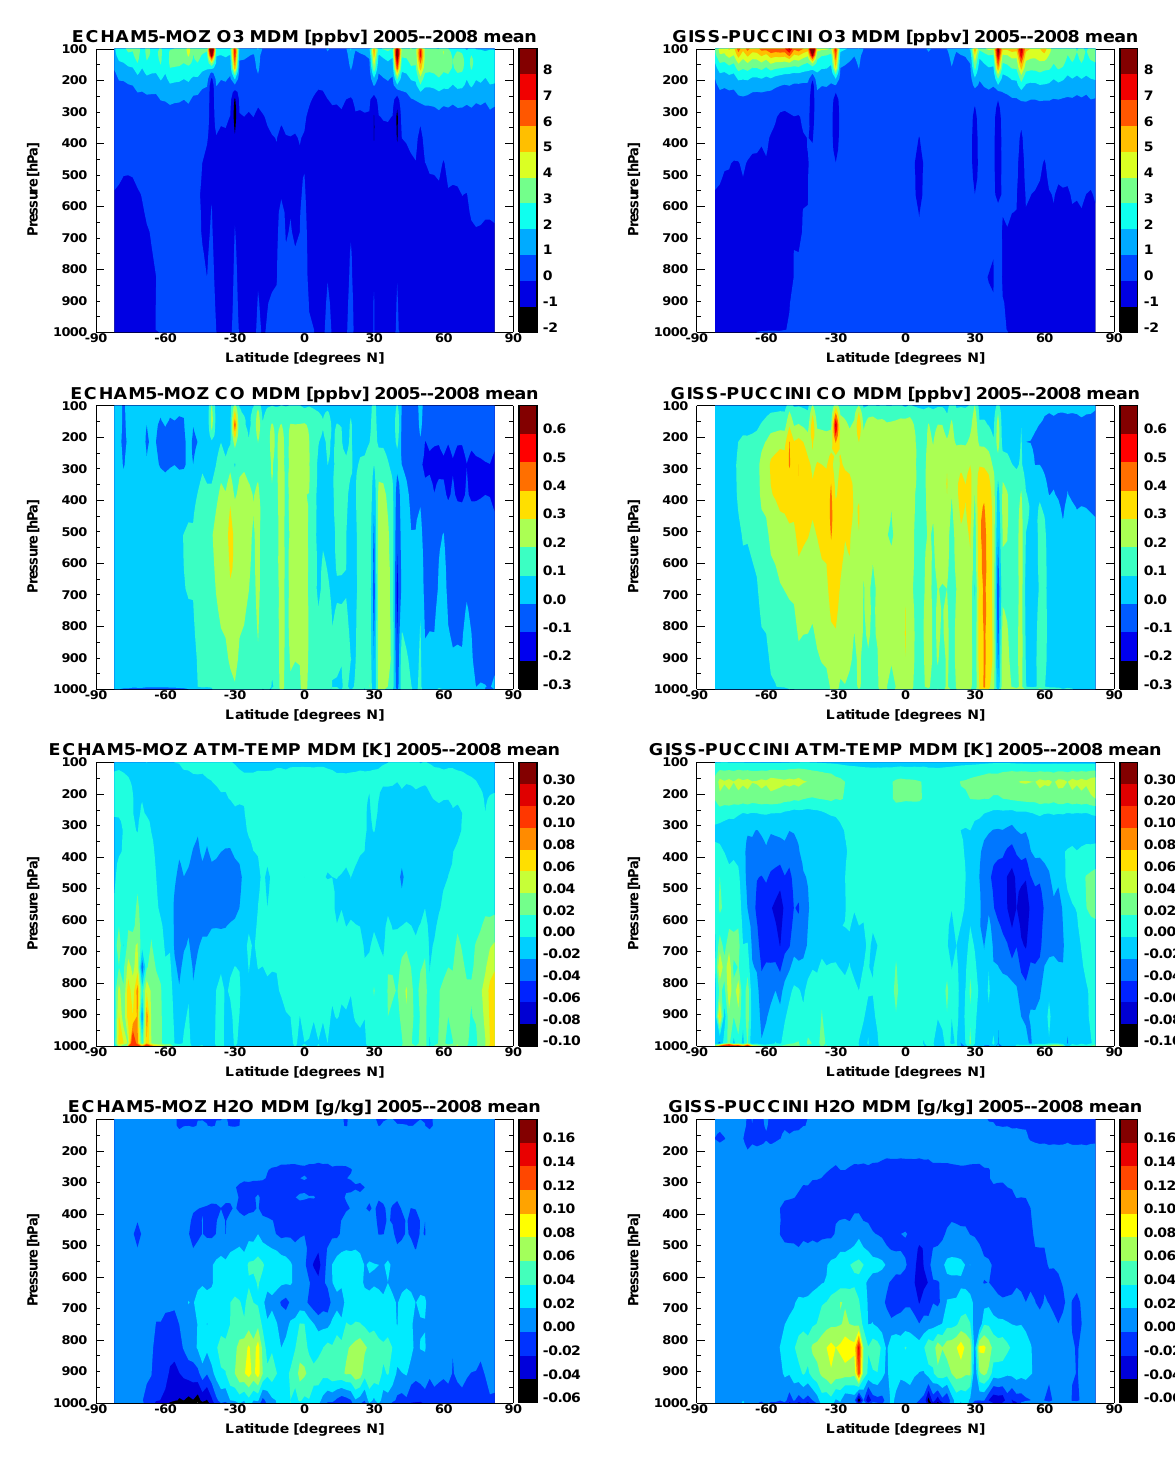
Fig. 8b. The 2005–2008 monthly-mean zonal-mean absolute errors due to averaging the satellite operators. The layout of the figures is similar to those in Fig. 8a for both